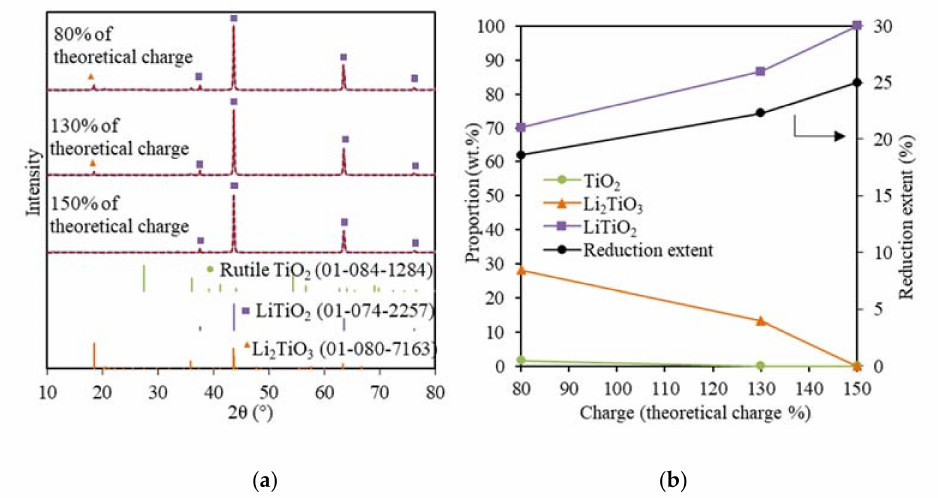
Figure 4. ( a ) XRD results (blue solid lines) and Rietveld refinement analysis (red dash lines) of the reduced TiO 2 samples at − 0.3 V vs. Li/Li + using 80%, 130%, and 150% of the theoretical charge; ( b ) reduced sample compositions and reduction extents for the TiO 2 reductions at − 0.3 V vs. Li/Li + using 80%, 130%, and 150% of the theoretical